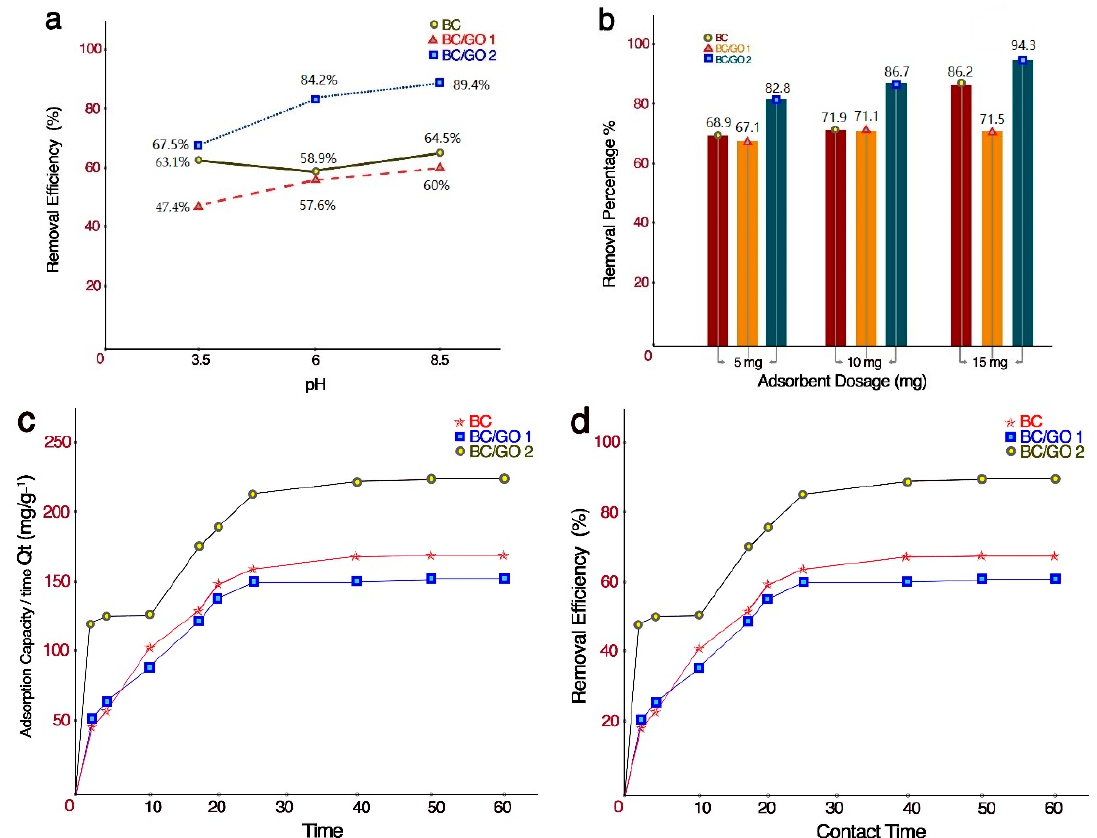
Figure 8. ( a ) Effect of solution pH on removal ( b ) Effect of adsorbent dosage on metal ion removal ( c , d ) Effect of contact time on metal ion removal.